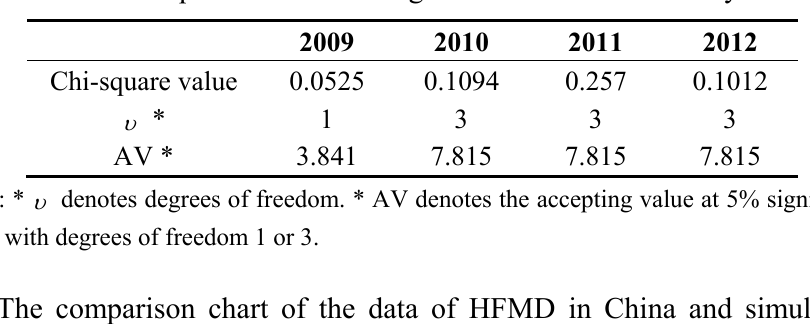
Table 3. Chi-square values and degrees of freedom for each year.